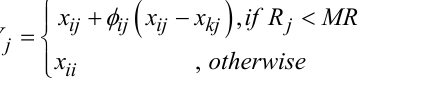
Table 2. data normalization and evaluation of pi Sr.